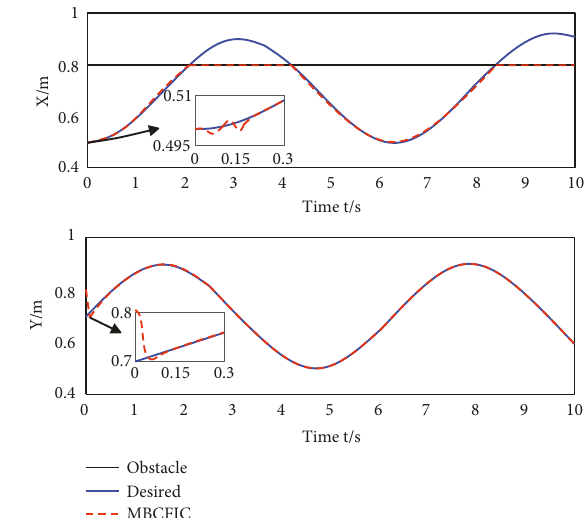
Figure 3: Position tracking curve (the model-based control